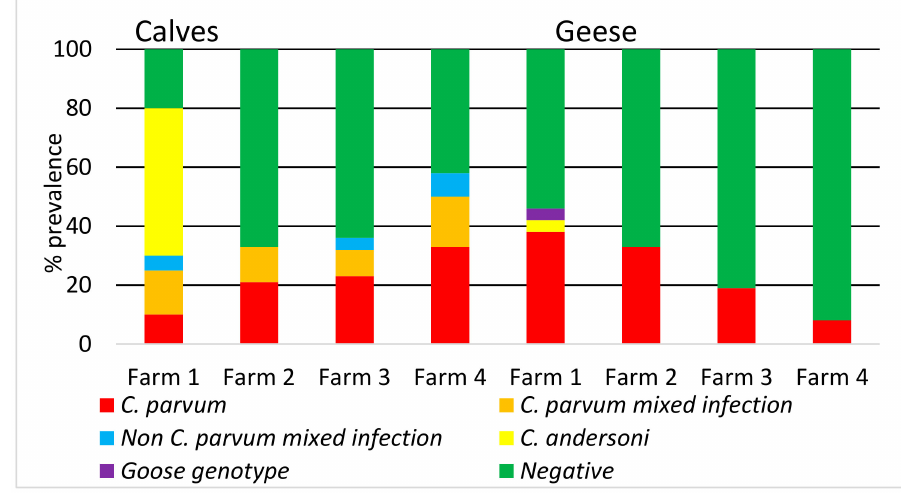
Figure 1. Cryptosporidium species prevalence (%) found on each farm in calves and